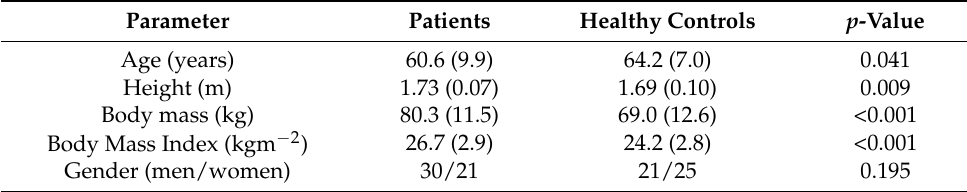
Table 1. Anthropometric data of the preoperative patients and healthy